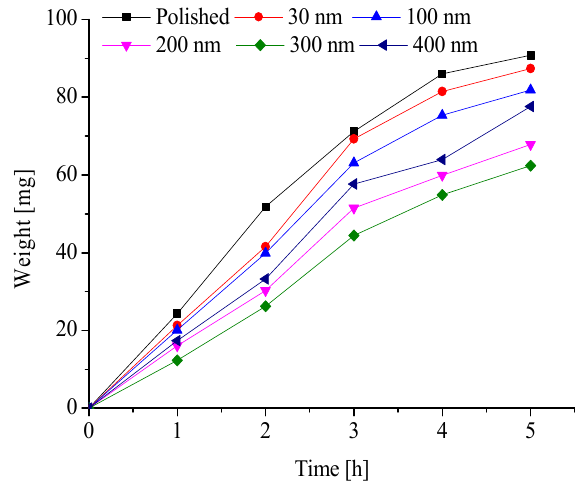
Figure 14. Variations of frost weight with different nanoporous diameters at T = − 25 °C, φ = 60%.